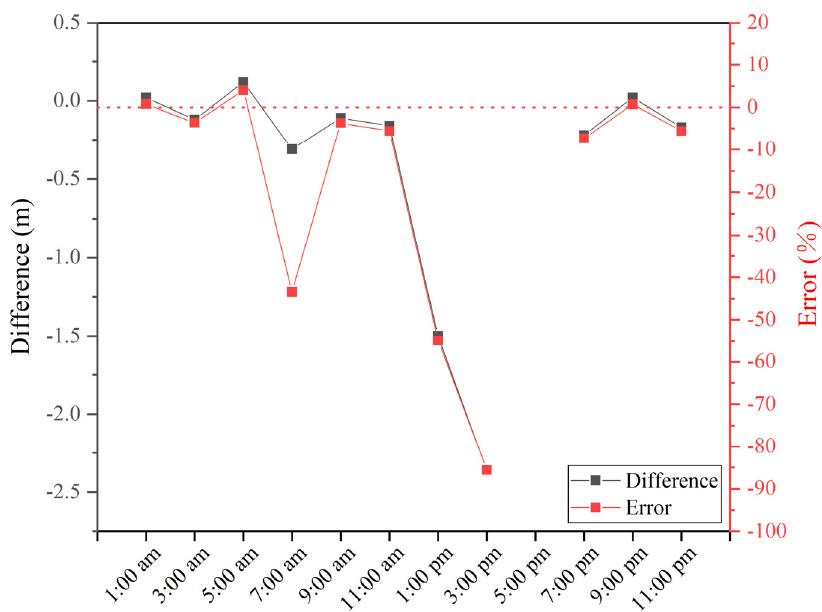
Figure 14. Differences and errors in Fissure I 1 length between infrared images and fissure detection